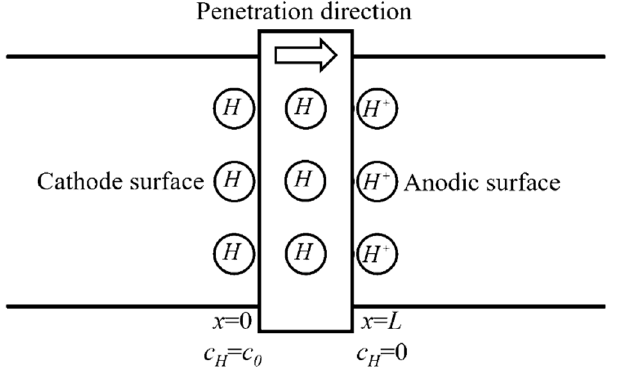
Figure 2. Schematic diagram of the hydrogen permeation model.